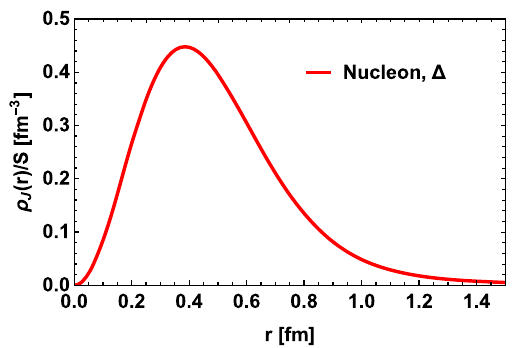
Fig. 1 The left panel presents the results for the monopole energy den- sities of the classical soliton (LO), the nucleon (NLO) and the (cid:2) (NLO) as functions of radius r . The right panel depicts the quadrupole energy